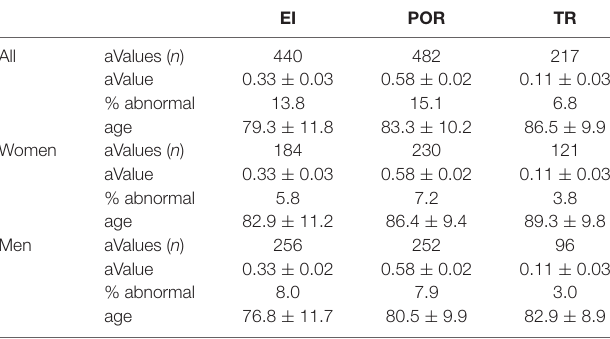
The eligible scans came from 1,711 women [53.6%, age